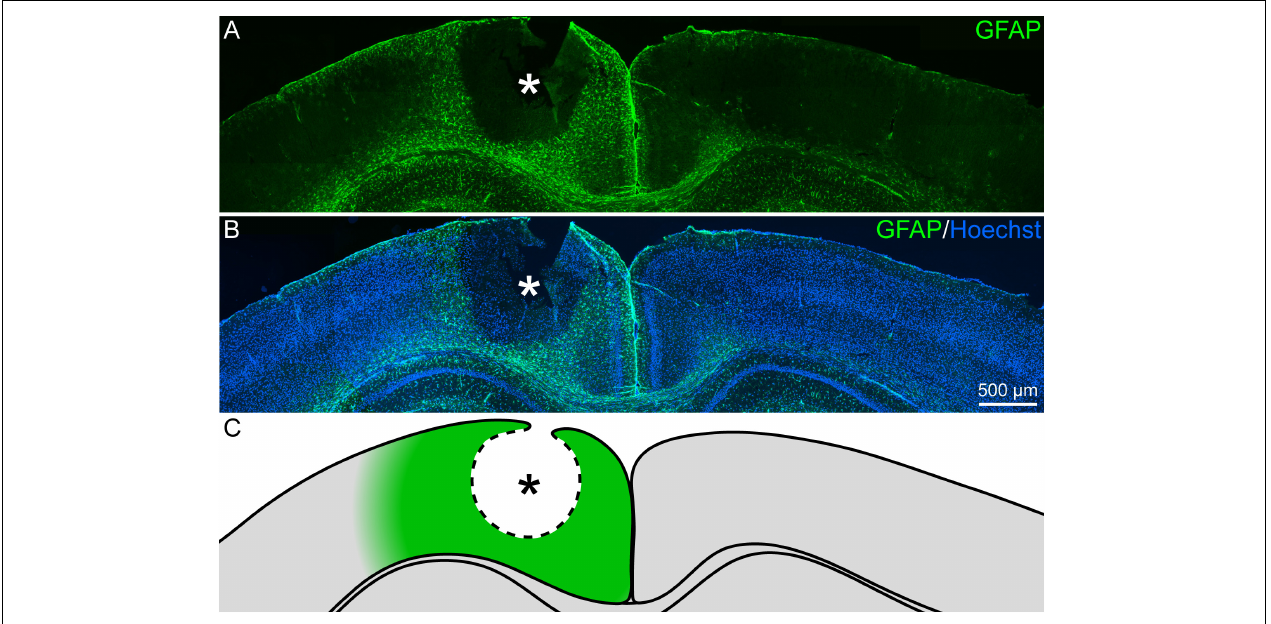
FIGURE 1 | Reactive gliosis after cortical laser lesion, 3 dpl. (A , B) GFAP-positive astrocytes appeared in the penumbra of the necrotic lesion core in the adult visual cortex (frontal brain section). Under healthy conditions, GFAP was only sparsely expressed. (C) Scheme of the lesion that indicates the penumbra around the lesion core in green. Asterisk: lesion core; Hoechst: nuclear counterstaining; scale bar: 500 µ m.